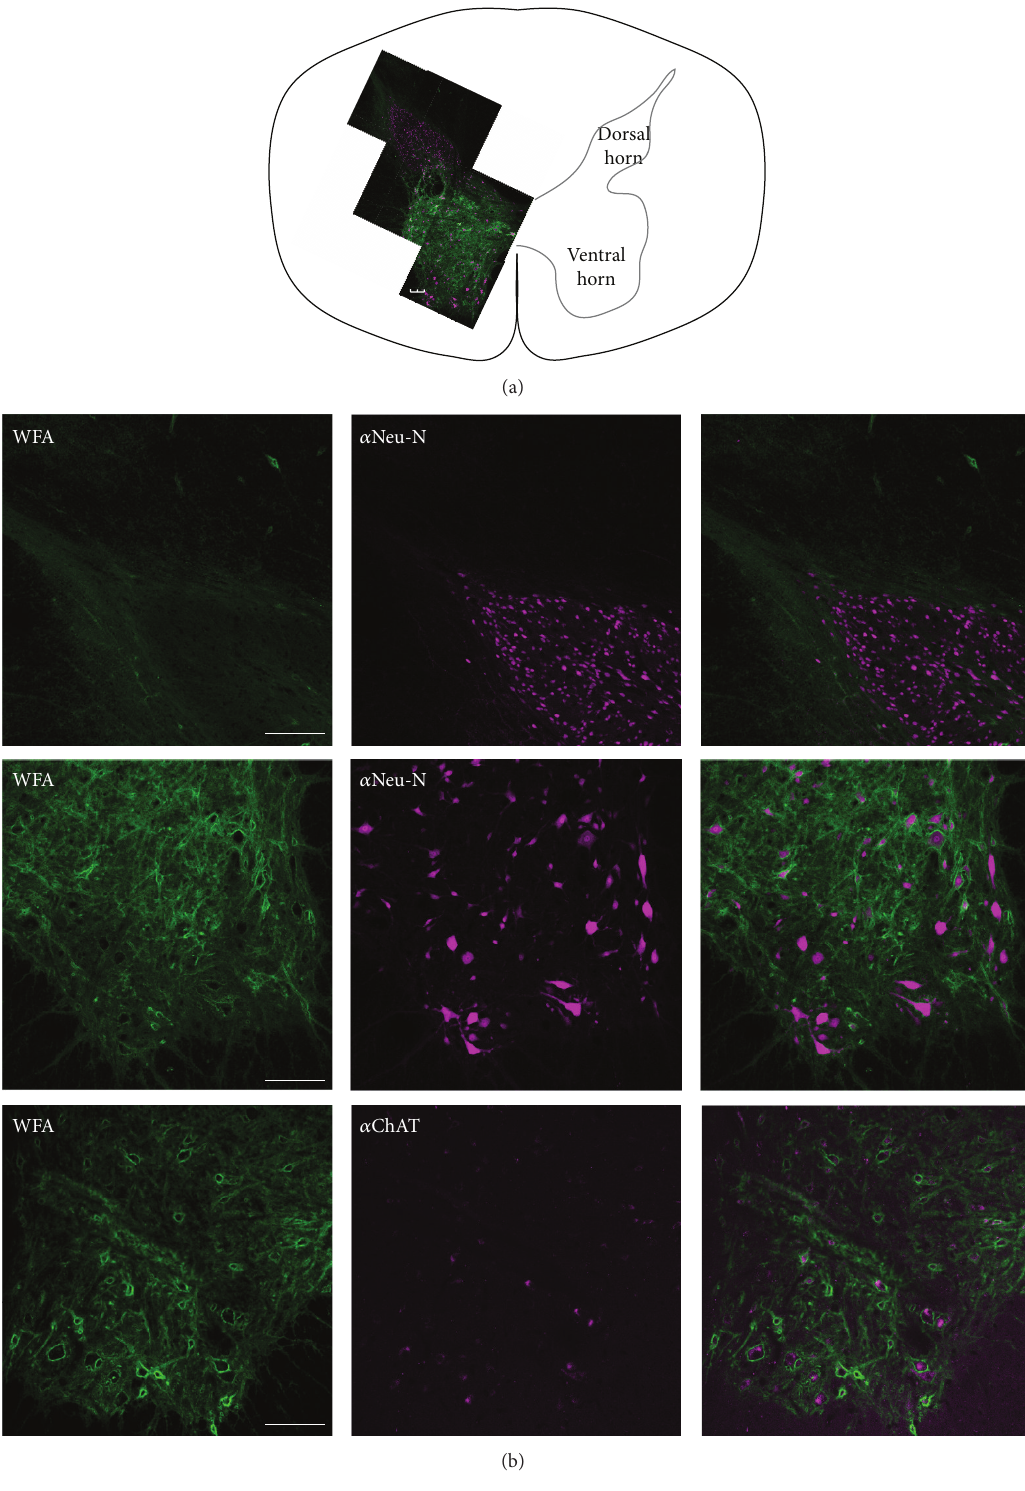
Figure 7: (a) Perineuronal nets in ventral and dorsal horns of the spinal cord. A composite image of perineuronal nets (stained with WFA) and neurons (stained with 𝛼 -NeuN) is superimposed on the left of a schematic of the cervical spinal cord. (b) Perineuronal nets (WFA+, green) are more prevalent around neurons (NeuN, pink) in the ventral spinal cord (middle panels) than in the dorsal spinal cord (top panels). Cells surrounded by PNNs are often ChAT+, putative primary motoneurons (bottom panels). Scale bars = 200 𝜇